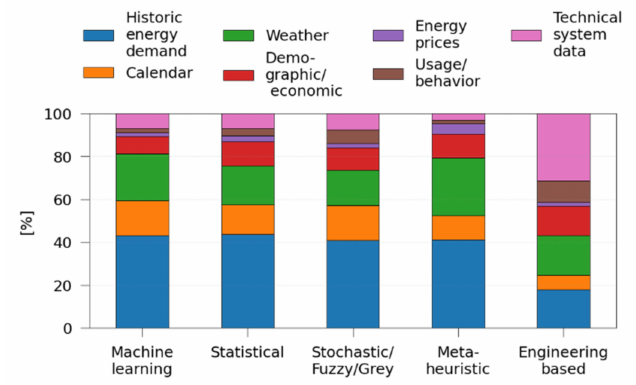
Figure 7. Input data type by the method. For each method, the relative share of the seven in- put data types is shown. Across all methods, engineering-based approaches rely less on historic energy